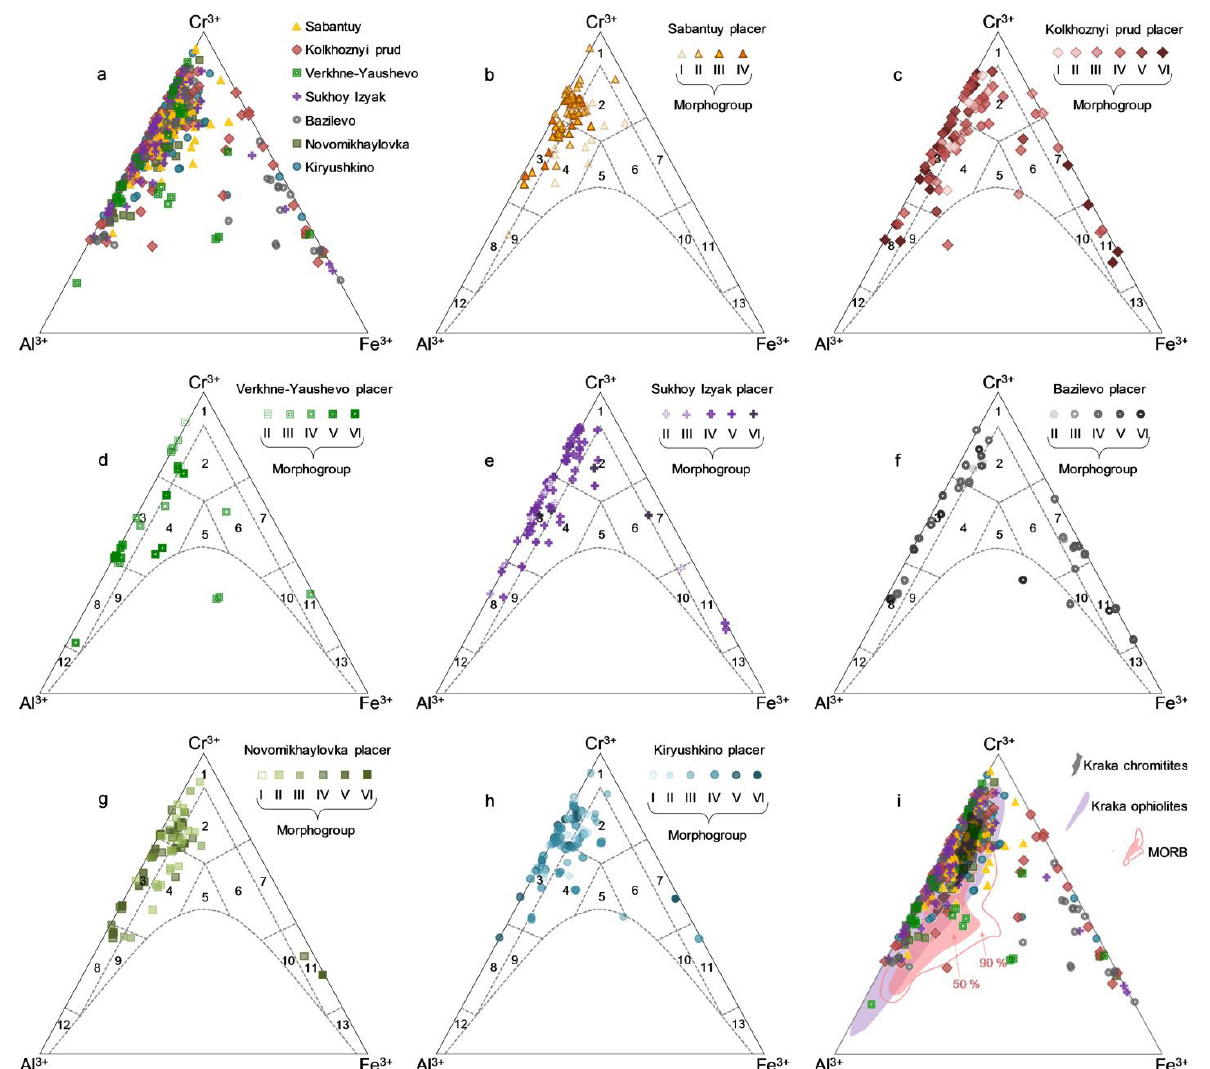
Figure 7. Ternary Al 3+ –Cr 3+ –Fe 3+ diagrams for chromian spinels from Southern Pre-Urals chromite paleoplacers: ( a )—compositions of all placers together, ( b )—compositions of Sabantuy